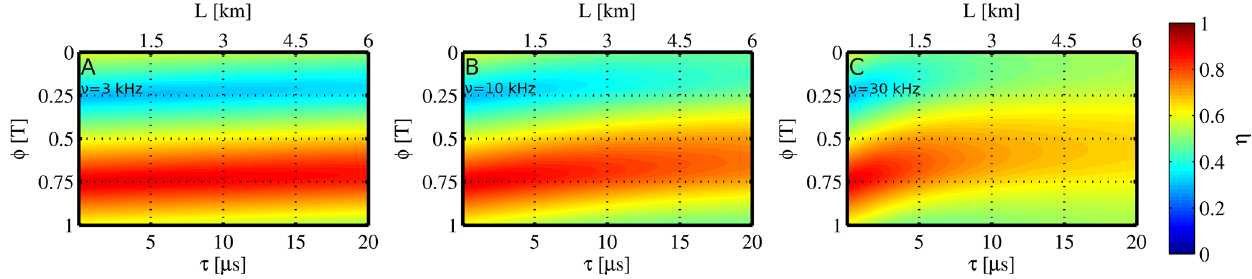
Figure 5. Apparent transmission η(τ,φ) = mean intensity at spectrometer (colour-coded) of the demonstration setup (Sect. 5.1, quasi-rectangular mean intensity at modulator I(t) and (cid:50)(t) profile), modelled for three different modulation frequencies ν . The characteristic landscape of η(τ,φ) can be used to retrieve the path